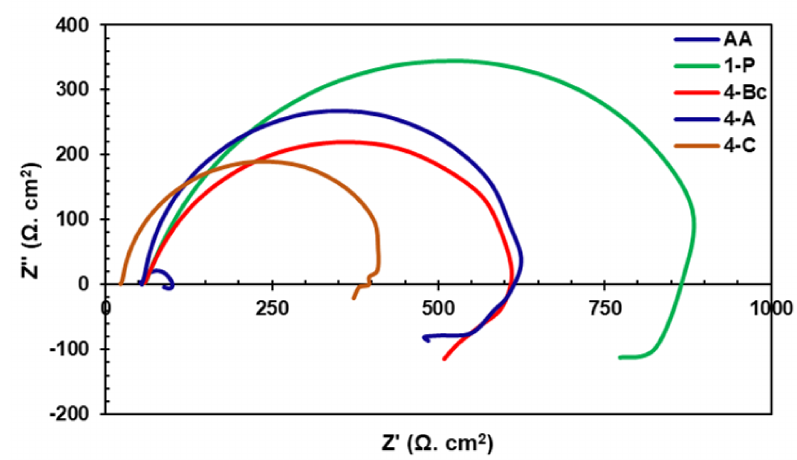
Figure 10. Nyquist plots of ZK30 alloy before and after ECAP processing.